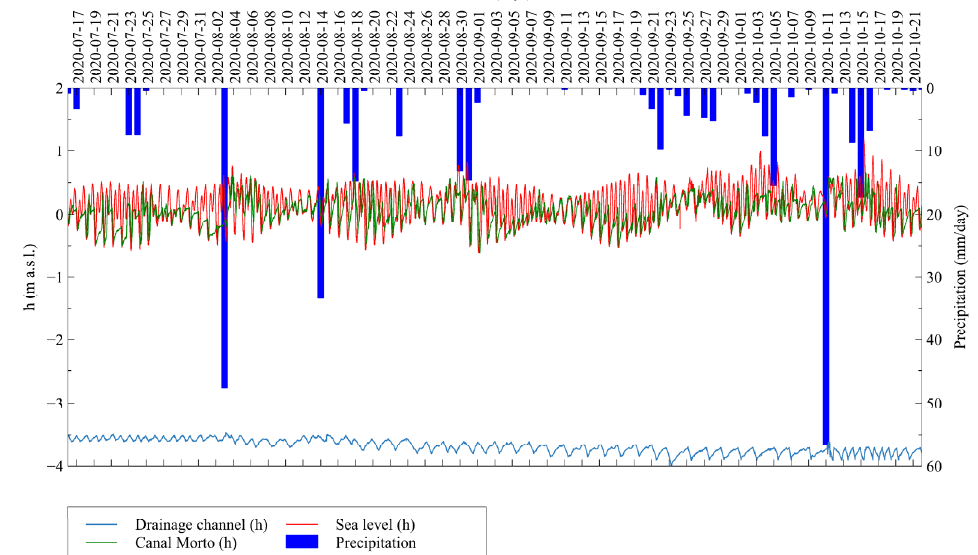
Figure 8. Time series of forcing factors of the aquifer dynamics in the southern Venice Lagoon during the period July 16th–October 22nd: Daily precipitation from SA meteorological station, Sea level observed at TG; CM water level (PS outflow) and DC h (PS